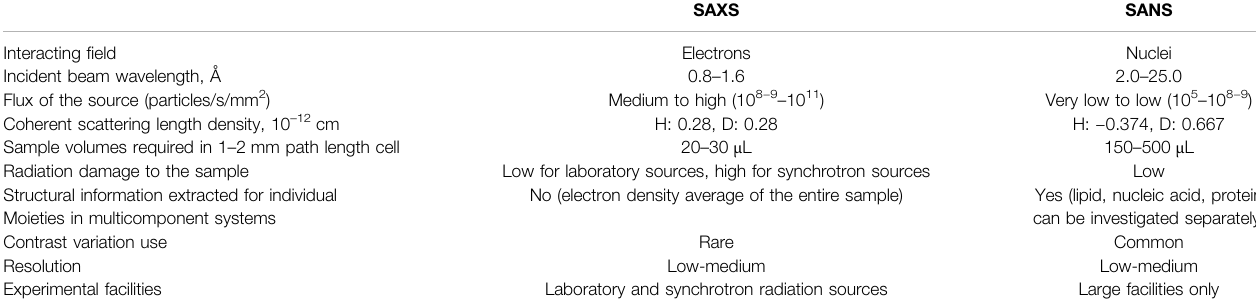
TABLE 1 | Differences and practicalities of SAXS and SANS experimental techniques [adapted from Tang and Blankenship (2012)].